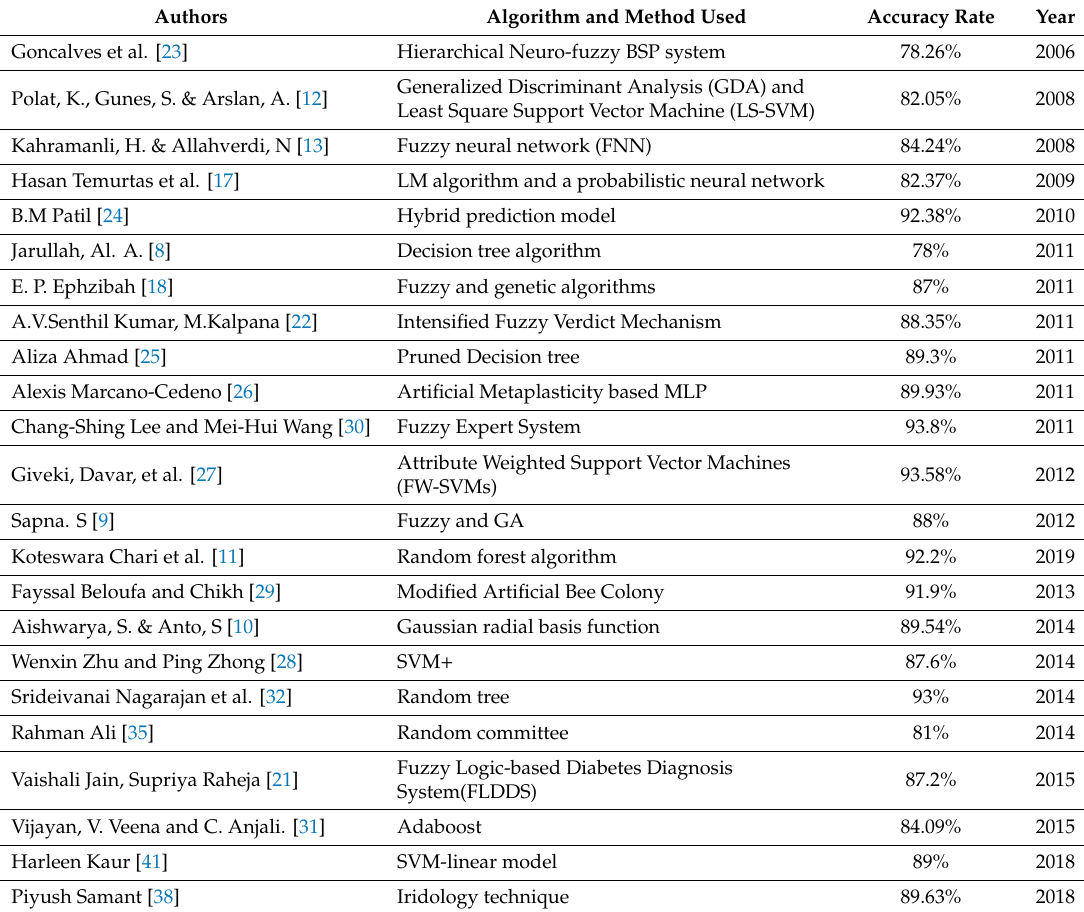
Table 1. Comparative analysis of the accuracy rate of similar existing